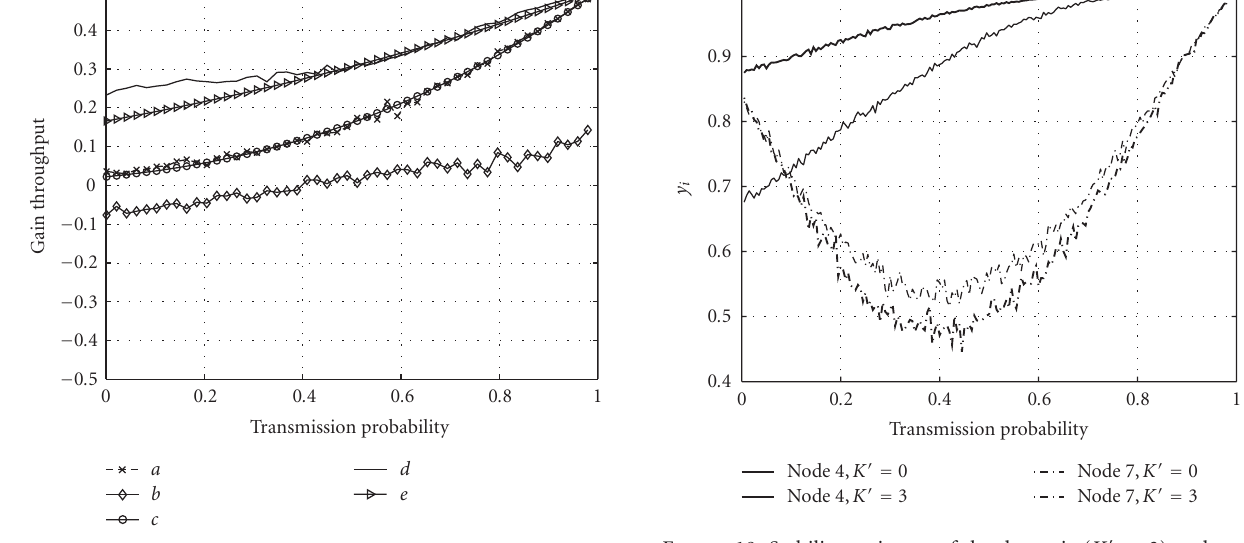
Figure 17: Throughput of the dynamic ( K (cid:5) = 2) and static ( K (cid:5) = 0) cases for K = 4 (asymmetric network of Figure 11).